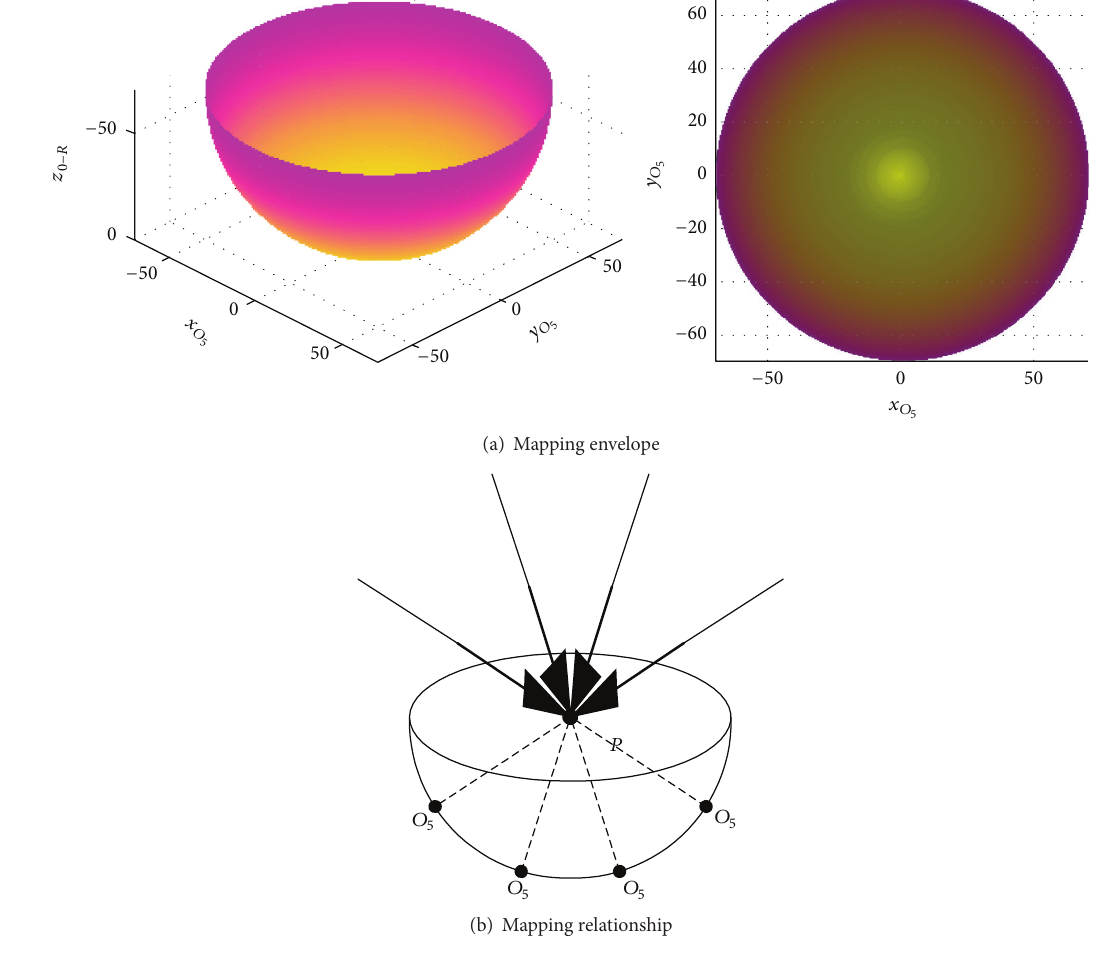
Figure 5: The example of 𝐿 𝑃 = −70 and 𝑒 = 0 .